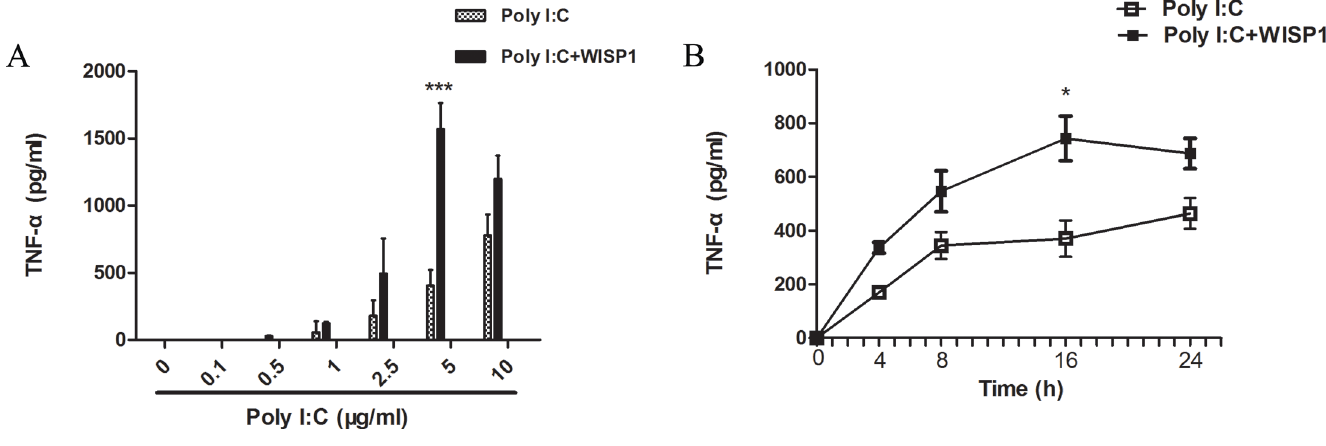
Figure 7. Effects of WISP1 on poly(I:C)-induced TNF- α production in macrophages. (A) Peritoneal macrophage isolated from C57BL/6J mice were treated with WISP1 (10 μ g/mL) in the presence or absence of various concentrations (0–10 μ g/mL) of poly(I:C) in serum-free medium for 16 h. TNF- α levels in the supernatant were measured by ELISA. (B) Peritoneal macrophage isolated from C57BL/6J mice were treated with WISP1(10 μ g/mL) in the presence or absence of poly(I:C) (5 μ g/mL) in serum-free medium for up to 24 h. TNF- α levels in the supernatant were measured by ELISA at 0 h, 4 h, 8 h, 12 h, 16 h, 20 h and 24 h after stimulation. Data are presented as mean ± SEM (n = 5) and compared by two-way ANOVA. For comparing the poly(I:C) + WISP1 group with the poly(I:C) alone group * P < 0.05, *** P < 0.001.